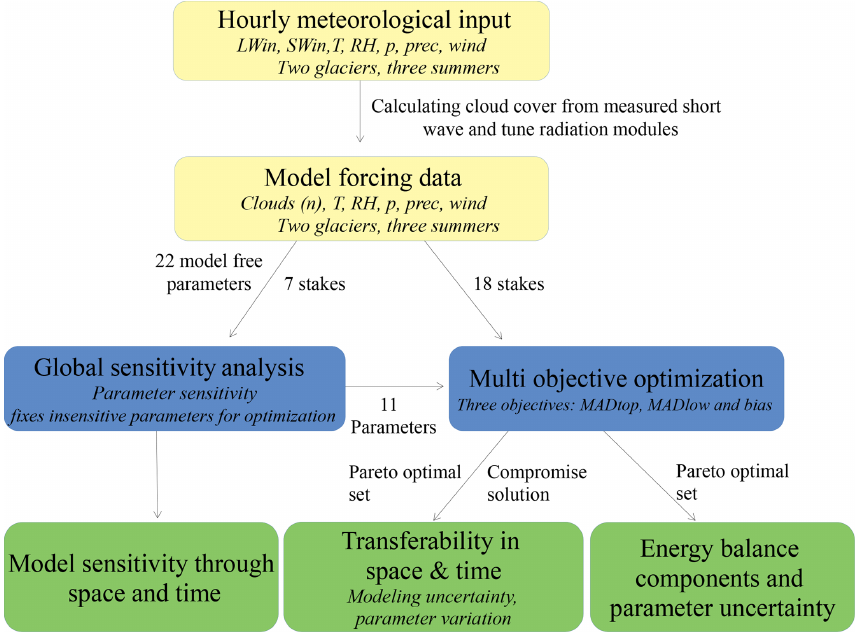
Figure 1. The sequential approach used in this study can be classified in three steps. First, data management and model setup in beige, the simulations (blue) first use a global sensitivity analysis to reduce the parameter space followed by a multi-objective optimization. All simulations are performed independently for three summers on two glaciers. The data analysis (green) is done independently for sensitivity, parameter and model uncertainty